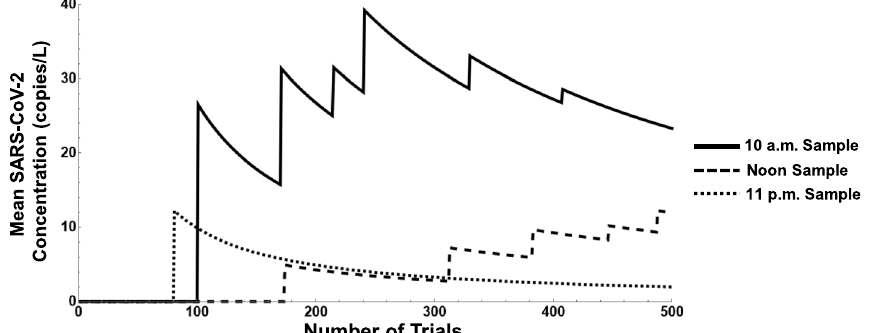
Fig. 5 Simulation output, rolling mean SARS-CoV-2 concentration (L/s) when population infection is 5%, viral load is 10 6 , and grab sample time